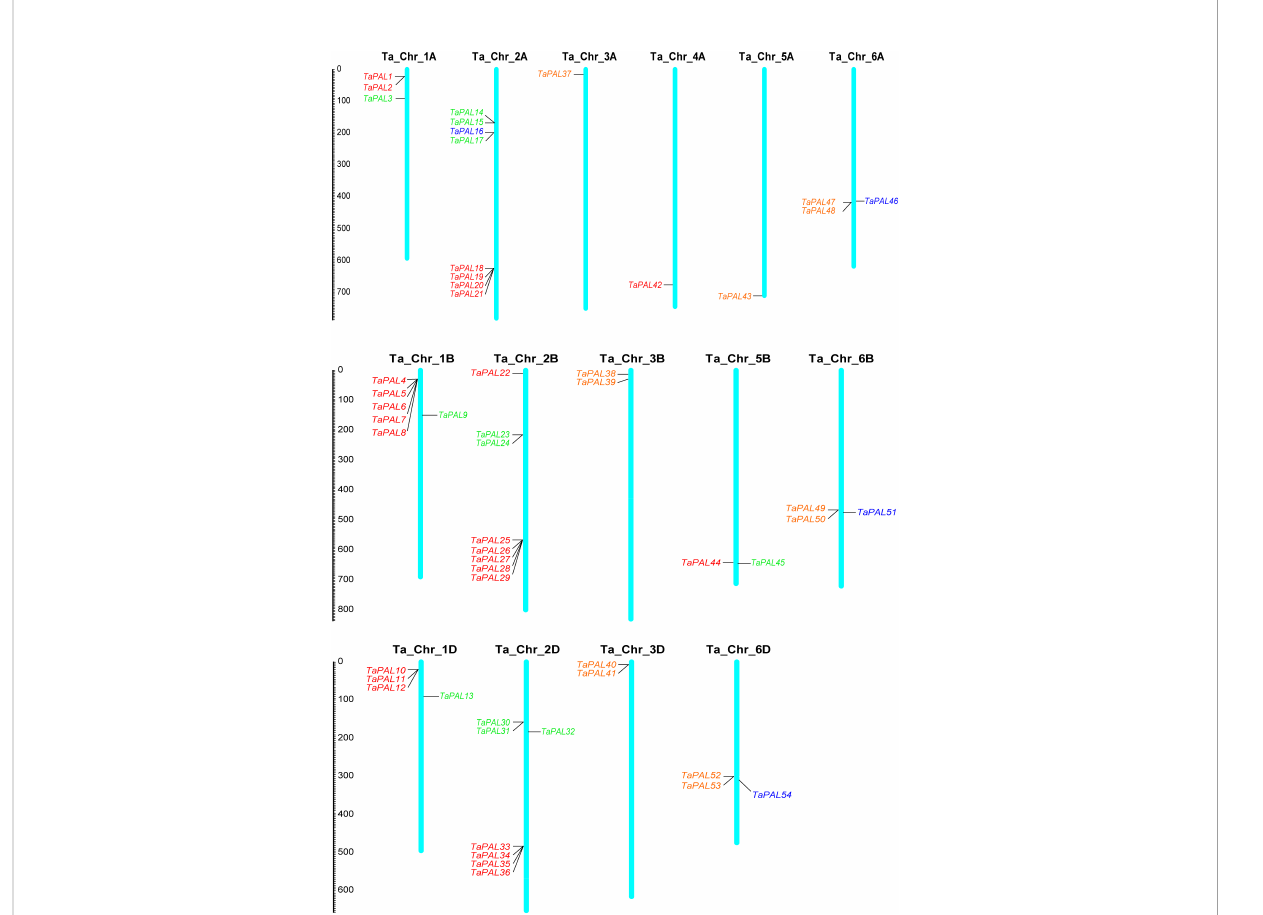
FIGURE 3 Chromosomal localization of the 54 TaPALs in wheat genome. Different classes of TaPALs are represented in different colors. Red represents TaPAL-I, green represents TaPAL-II, blue represents TaPAL-III, and orange represents TaPAL-IV. In addition, Ta represents wheat ( Triticum aestivum ), Chr represents